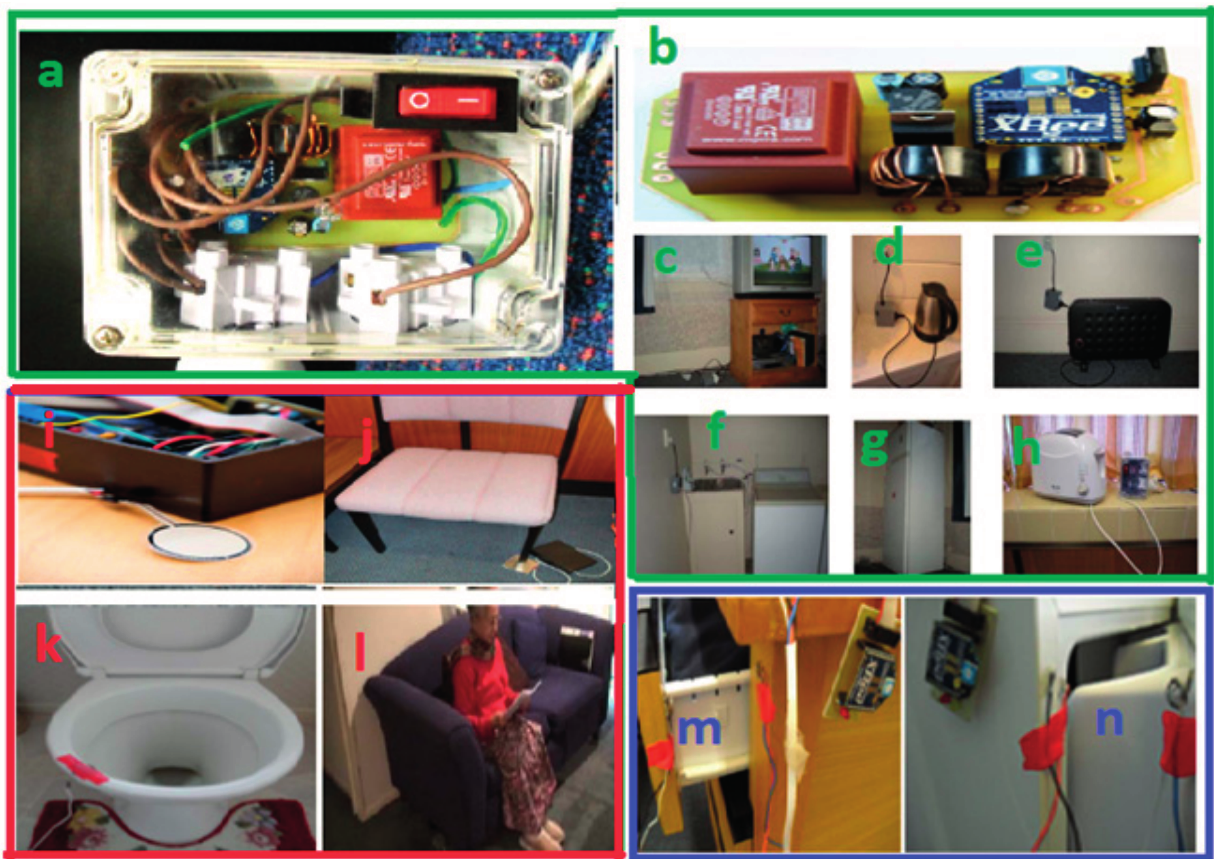
Figure 3. ( a , b ) represent the electronic and electrical appliance usage monitoring and control unit and ( c – h ) represent the monitoring and control of household appliances through this unit; ( i ) represents the force sensing unit and ( j – l ) deployment of the unit for different sitting as well as sleeping objects; ( m , n ) represent the contact sensing unit arrangement